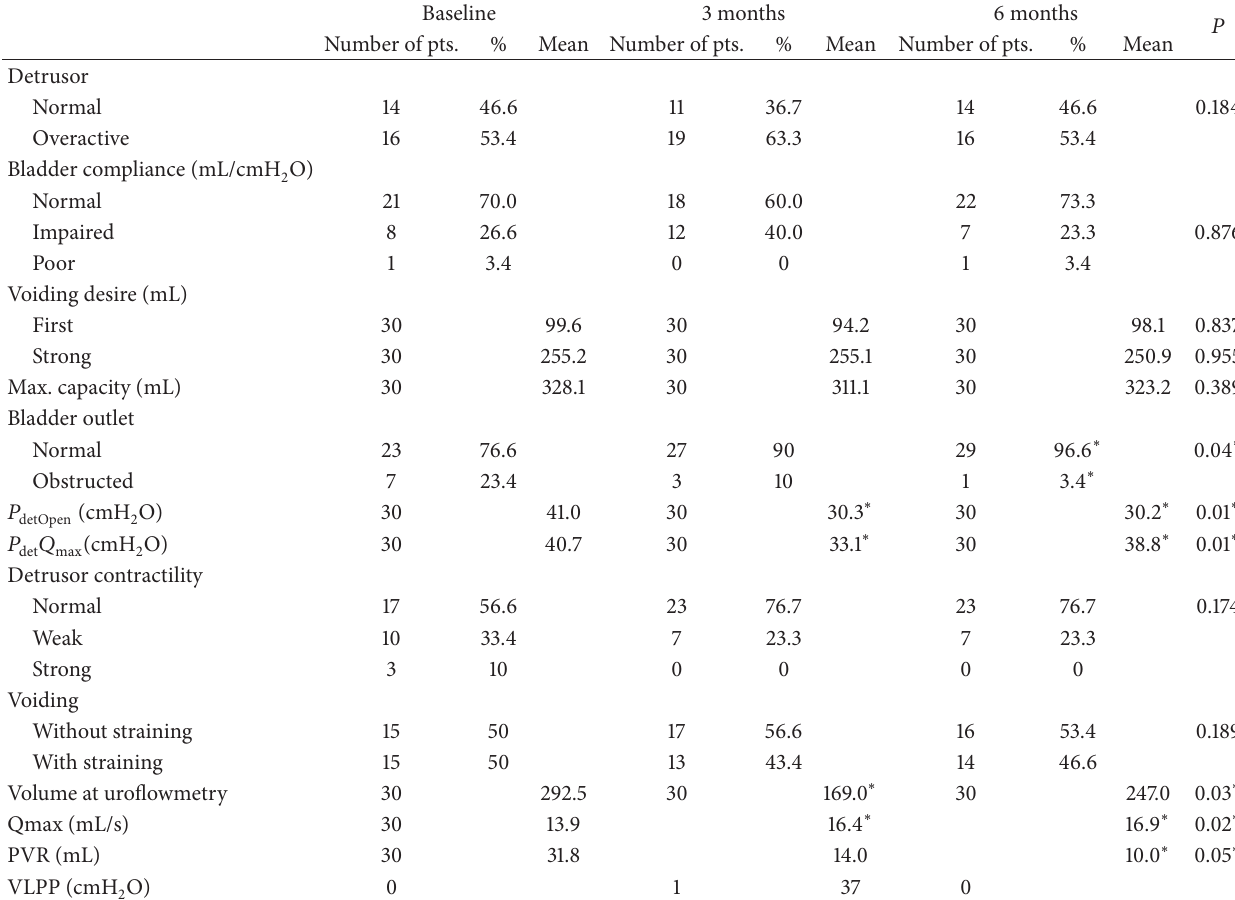
Table 2: Data relative to urodynamic studies. Main patterns of storage and voiding phases.